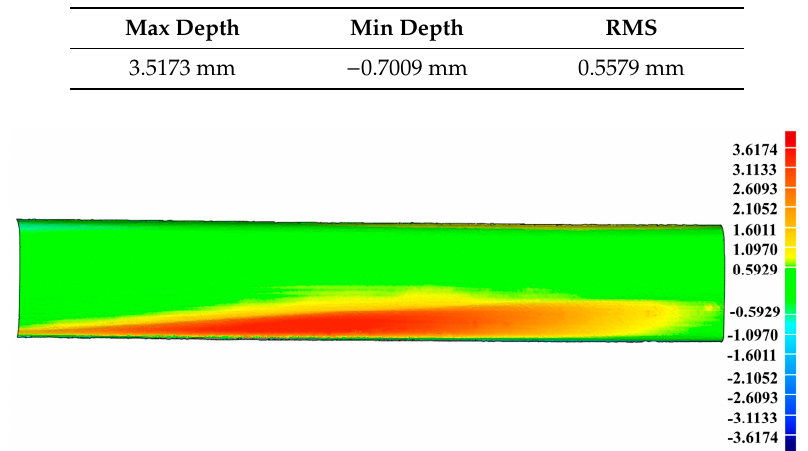
Figure 20. The specific places on the artificial rail surface with scratch-depth larger than 1 mm. Table 8. The analysis result of the artificial damaged rail.